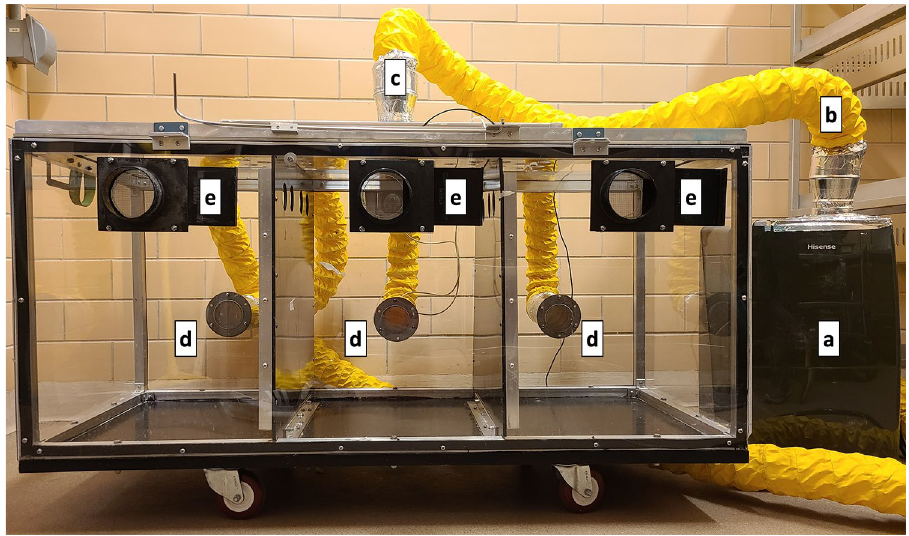
Figure 1. Environmental chamber. (a) 70-pint dehumidifier with vertical outflow captured by a plenum into 4-inch ducting (b) to an intake plenum on the roof of the environmental chamber (c). Air flowed out of the chamber through three ports (d) in the rear wall, which fed back into the dehumidifier through 4-in. ducting. Room air was titrated through closable ports (e) on the front wall of the